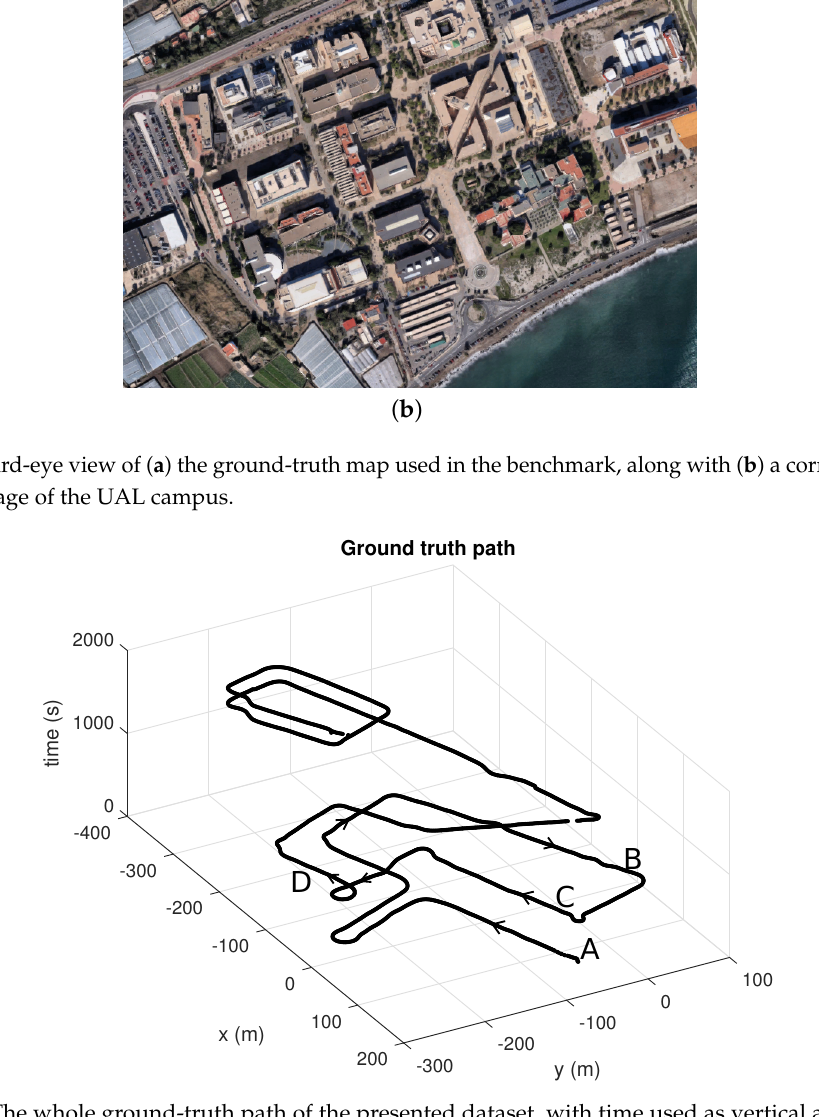
Figure 7. The whole ground-truth path of the presented dataset, with time used as vertical axis to help identifying the loops. Please compare with Figure 6 for